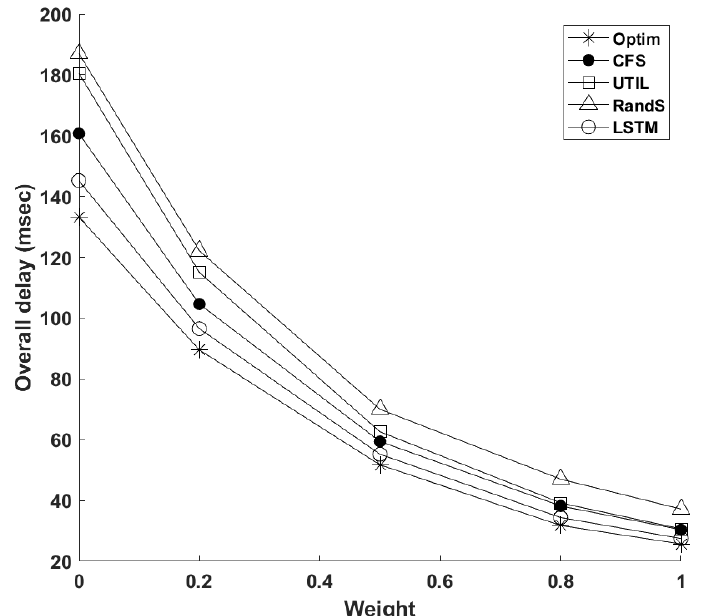
Figure 6. Service delay with weight µ (6 EC, 30 requests, EC capacity is 14 and total mobility probability is 1). CFS [34]; UTIL [35].